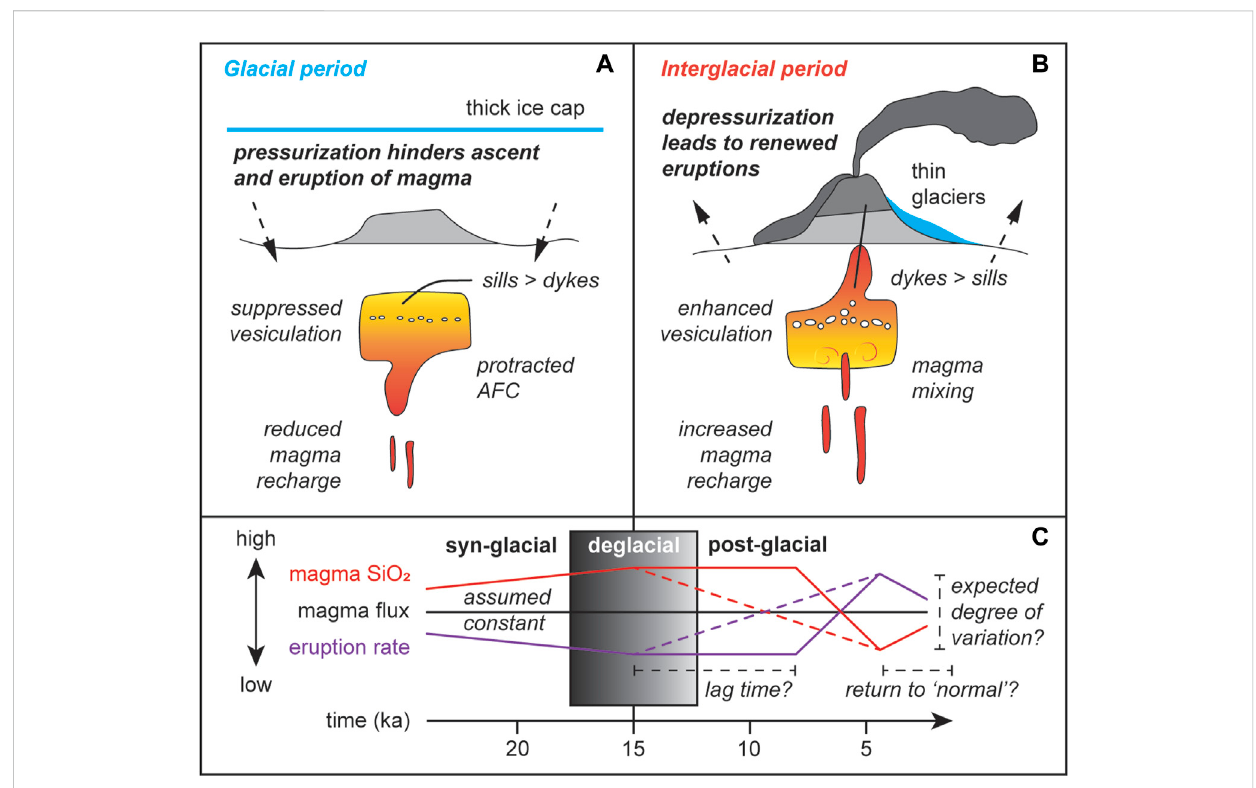
FIGURE 1 Summaryofthehypothesisthat (A) iceloadingonvolcanoessuppressesvolcanicactivityandthat (B) deglaciationcausesincreasederuptionratesat volcanoes for aconstant supply ofmagma into thecrust. (C) The predicted effects ofdeglaciationon eruptiverates and whole-rock SiO 2 concentrations for the ~25 to 5 ka interval, which includes the LGM and last deglaciation. Studies have postulated a lag between deglaciation and changes in eruptive rates and compositions due to gradual magma system depressurization (e.g., Jellinek et al., 2004; Rawson et al., 2016; Wilson and Russell, 2020). In (C) , the decrease in SiO 2 concentrations after 10 ka represents the transition from the situation in (A) where suppressed vesiculation and ascent causes stalled magmas to evolve to elevatedSiO 2 concentrations to (B) where depressurization after deglaciation allows low-SiO 2 magmas to ascendand erupt more often with less time differentiating in the crust.